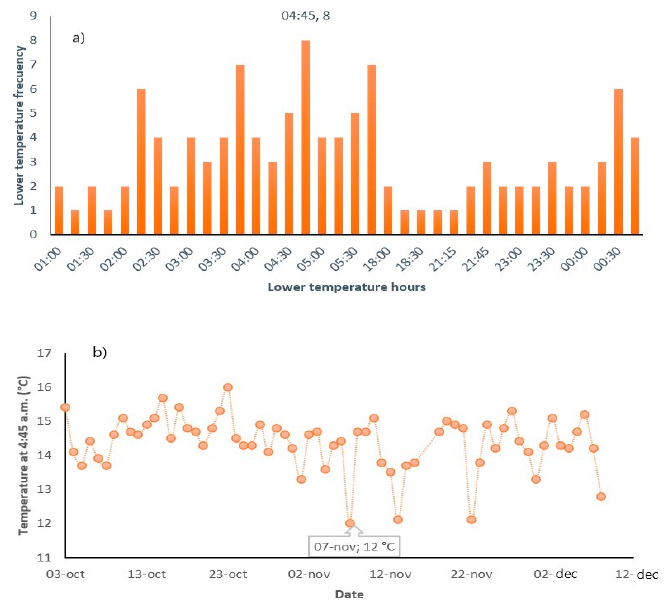
Figure 3. ( a ) Frequency analysis of the hours with lower temperatures in the daytime period. ( b ) Temperature values at 04:45 am of the daytime period. Table 2. Values of climatic variables considered in the case studies.